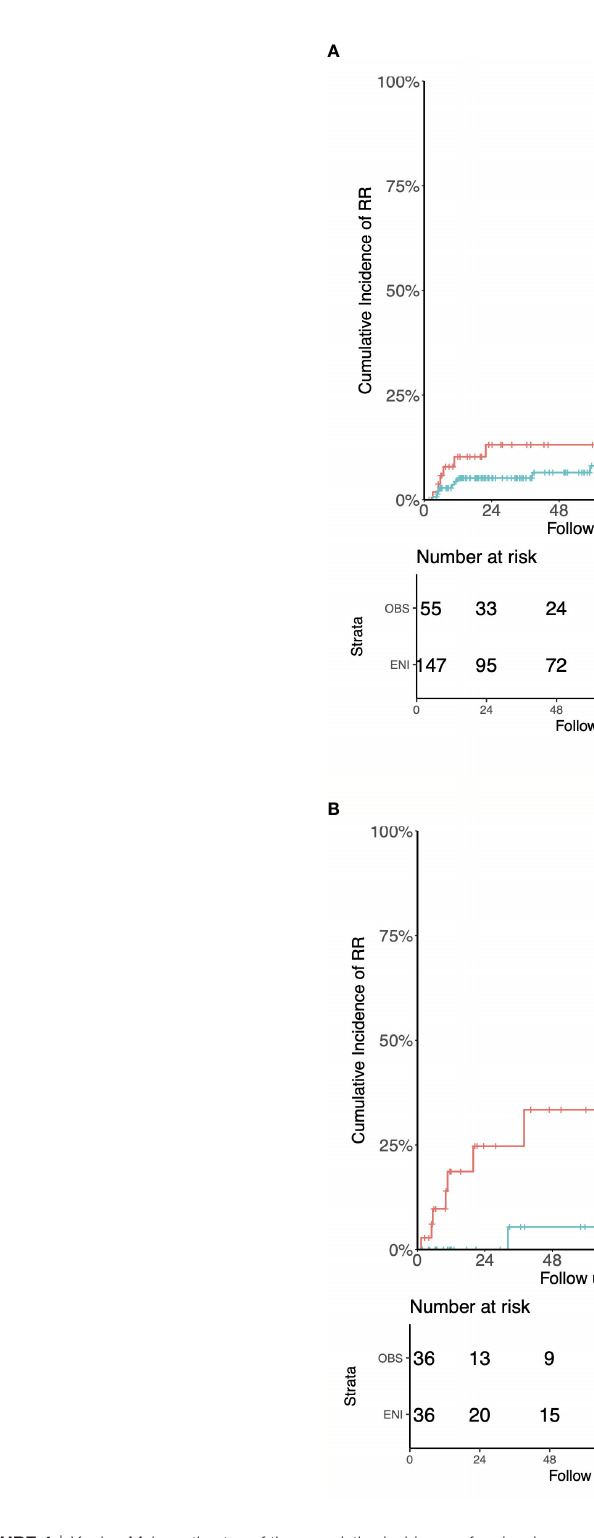
FIGURE 4 | Kaplan-Meier estimates of the cumulative incidence of regional recurrence in the ENI and OBS groups. (A) Regional Recurrence in the entire cohort. (B) Regional Recurrence in the matched